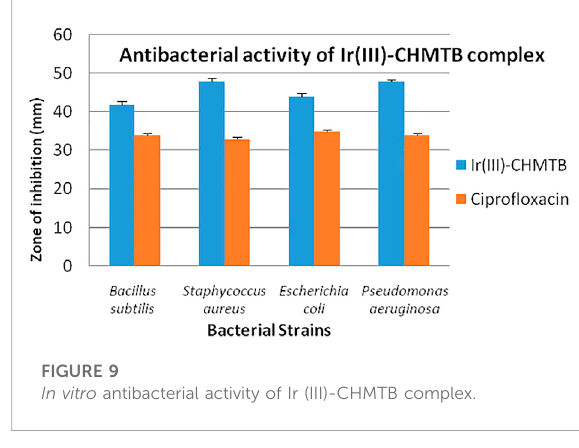
FIGURE 9 In vitro antibacterial activity of Ir (III)-CHMTB complex.